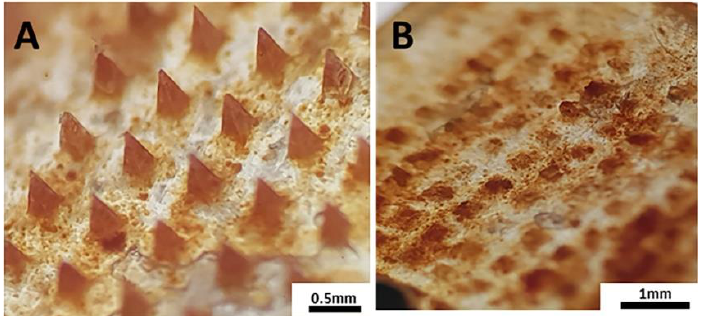
Figure 1. Characterization of PRN-loaded MN applied to ex vivo porcine ear skin. Optical image of ( A ) PRN-loaded MN patch before application and ( B ) PRN-loaded MN patch after application.